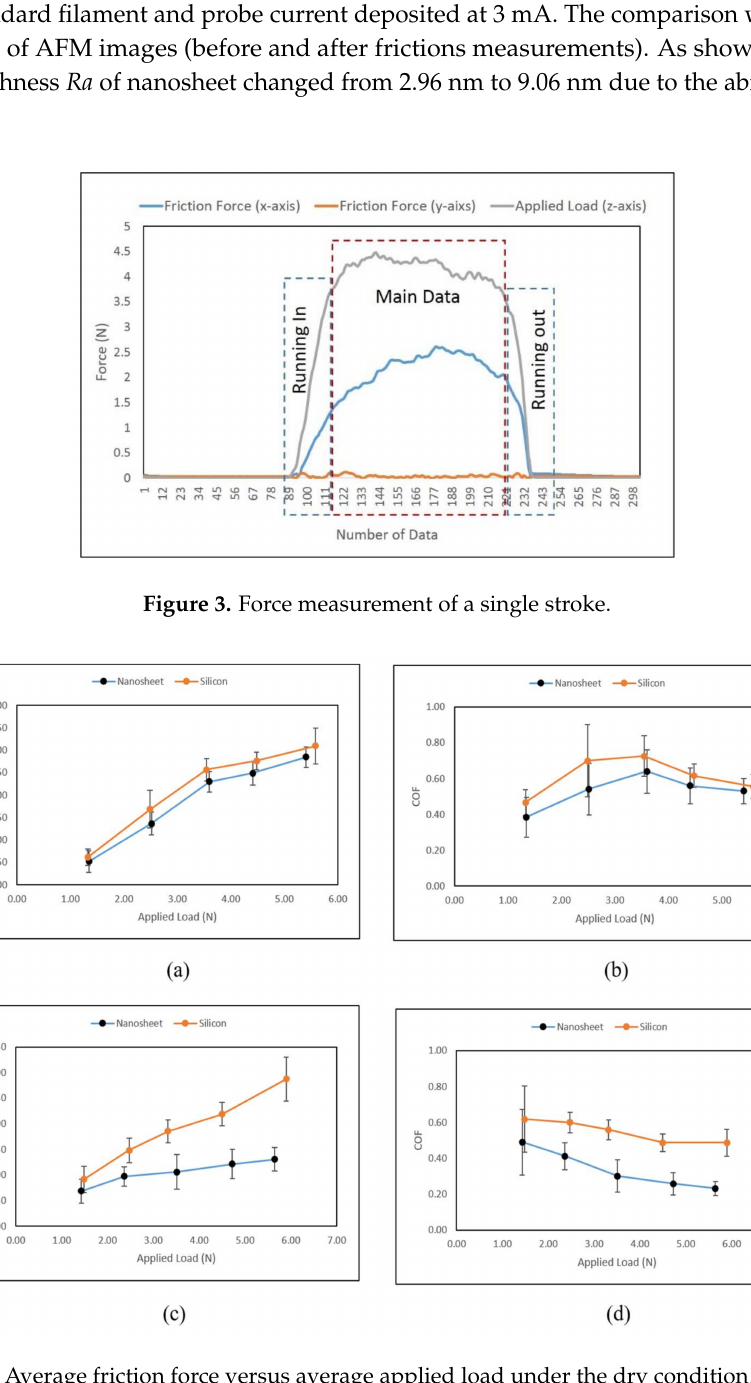
Figure 4. ( a ) Average friction force versus average applied load under the dry condition; ( b ) Average coefficient of friction (COF) versus applied load under the dry condition; ( c ) Average friction force versus average applied load under the wet condition; ( d ) Average COF versus applied load under the wet